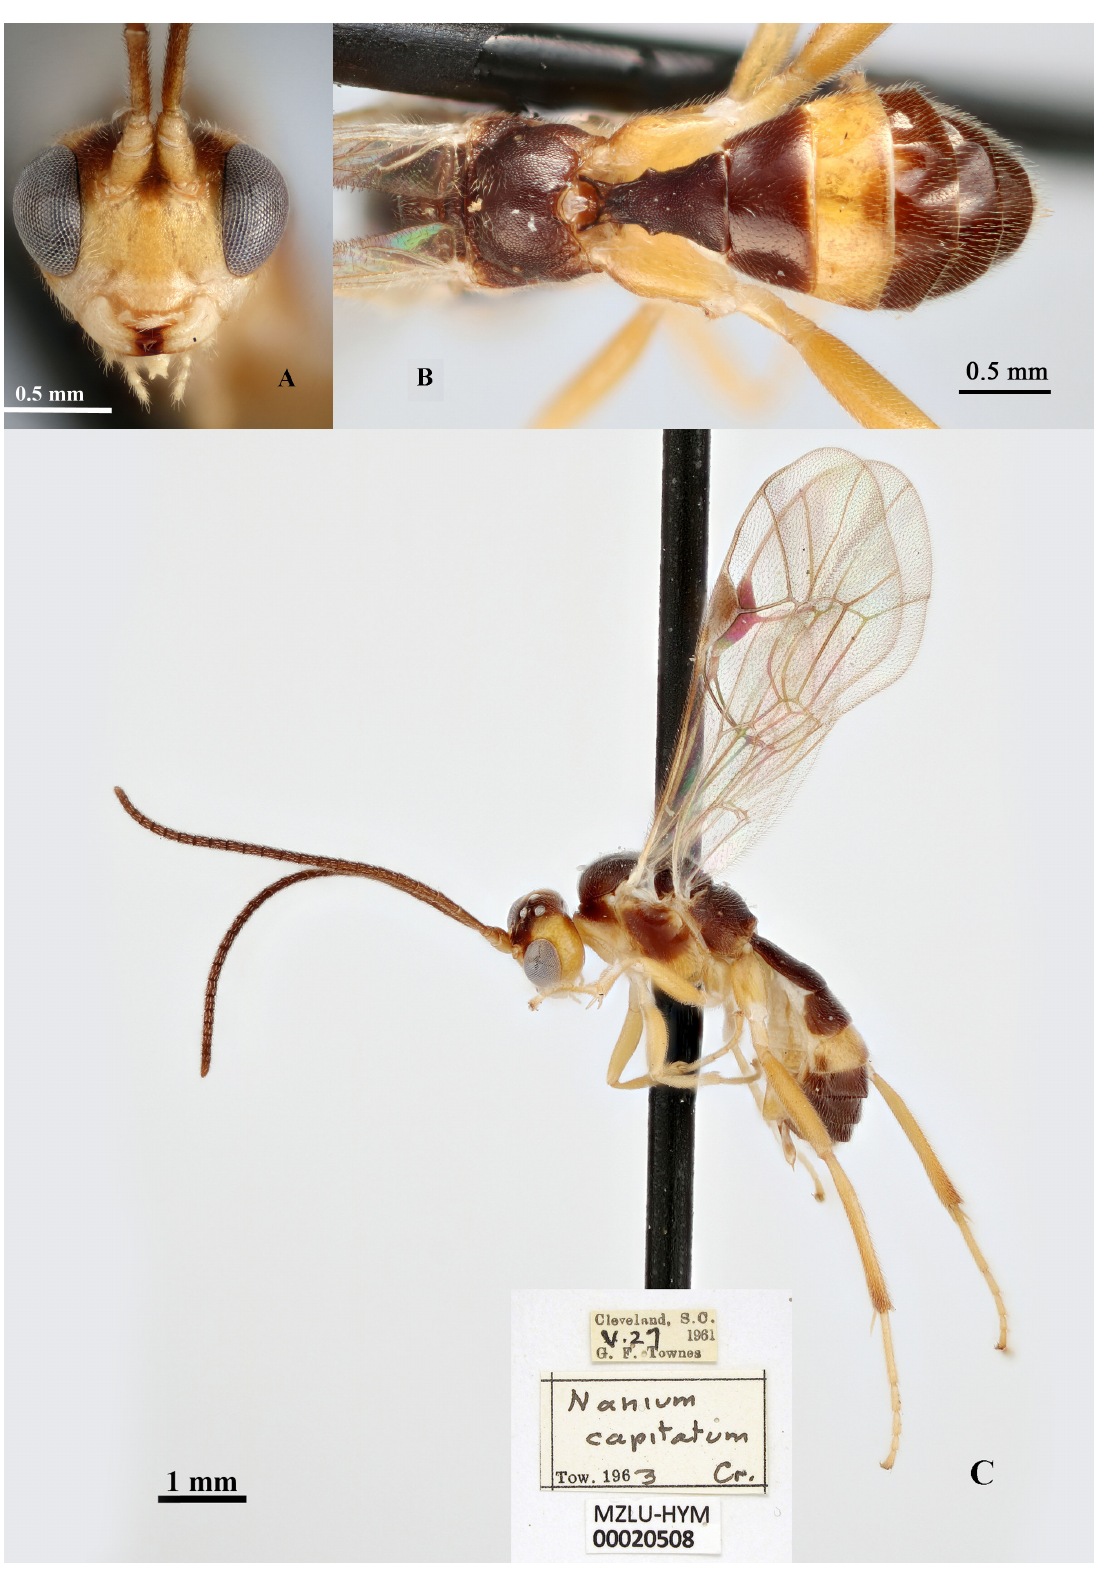
Fig. 3 . Nanium capitatum Townes, 1967, ♀ (MZLU-HYM 00020508). A . Face (frontal view). B . Metasoma (dorsal view). C .